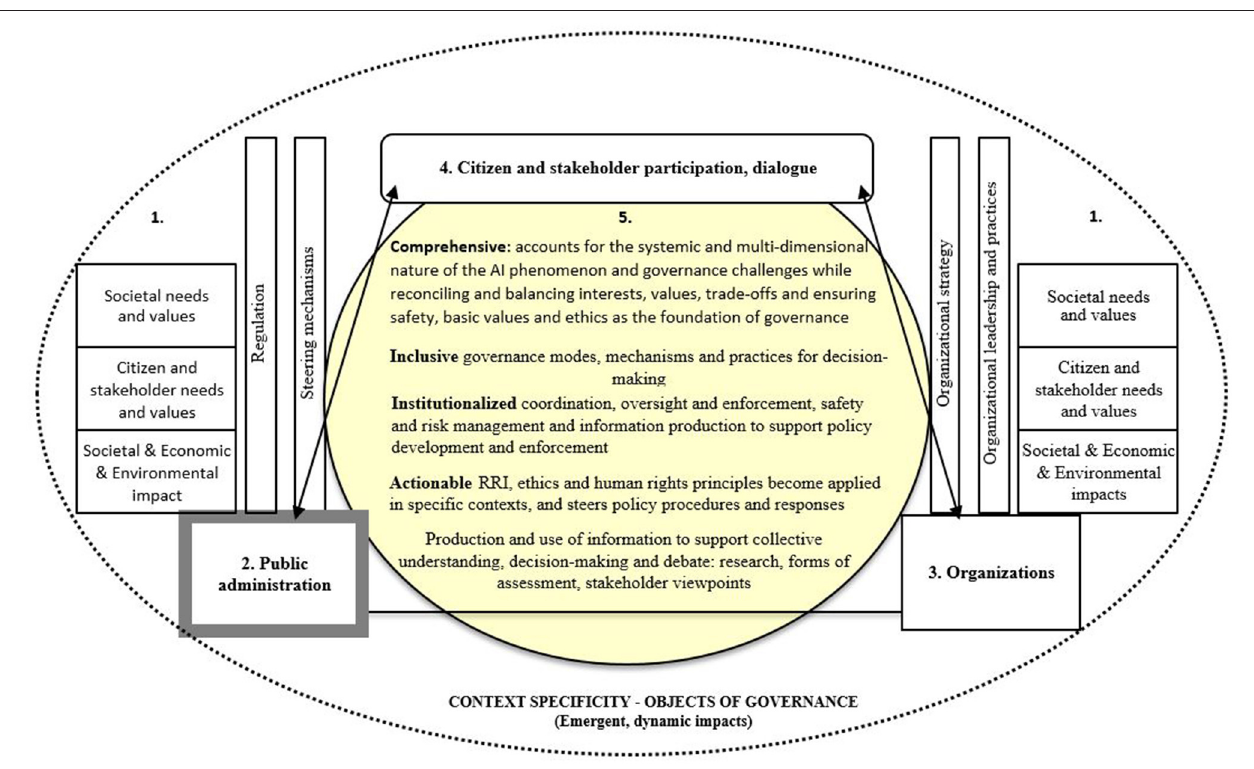
FIGURE 2 | Comprehensive, inclusive, institutionalized, and actionable framework of AI governance